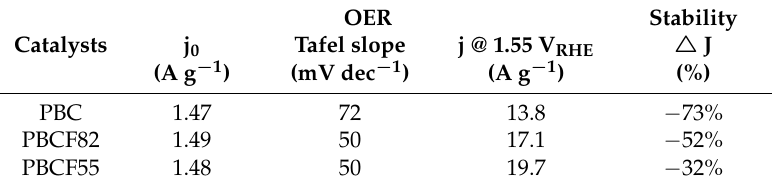
Table 1. Summary of electrochemical study results on oxygen evolution reaction activity and stability: mass-specific current density at 1.54 V, and stability expressed as percent of initial mass-specific current density after the 500 cycles of stepping between 1.0 V RHE and 1.6V RHE.